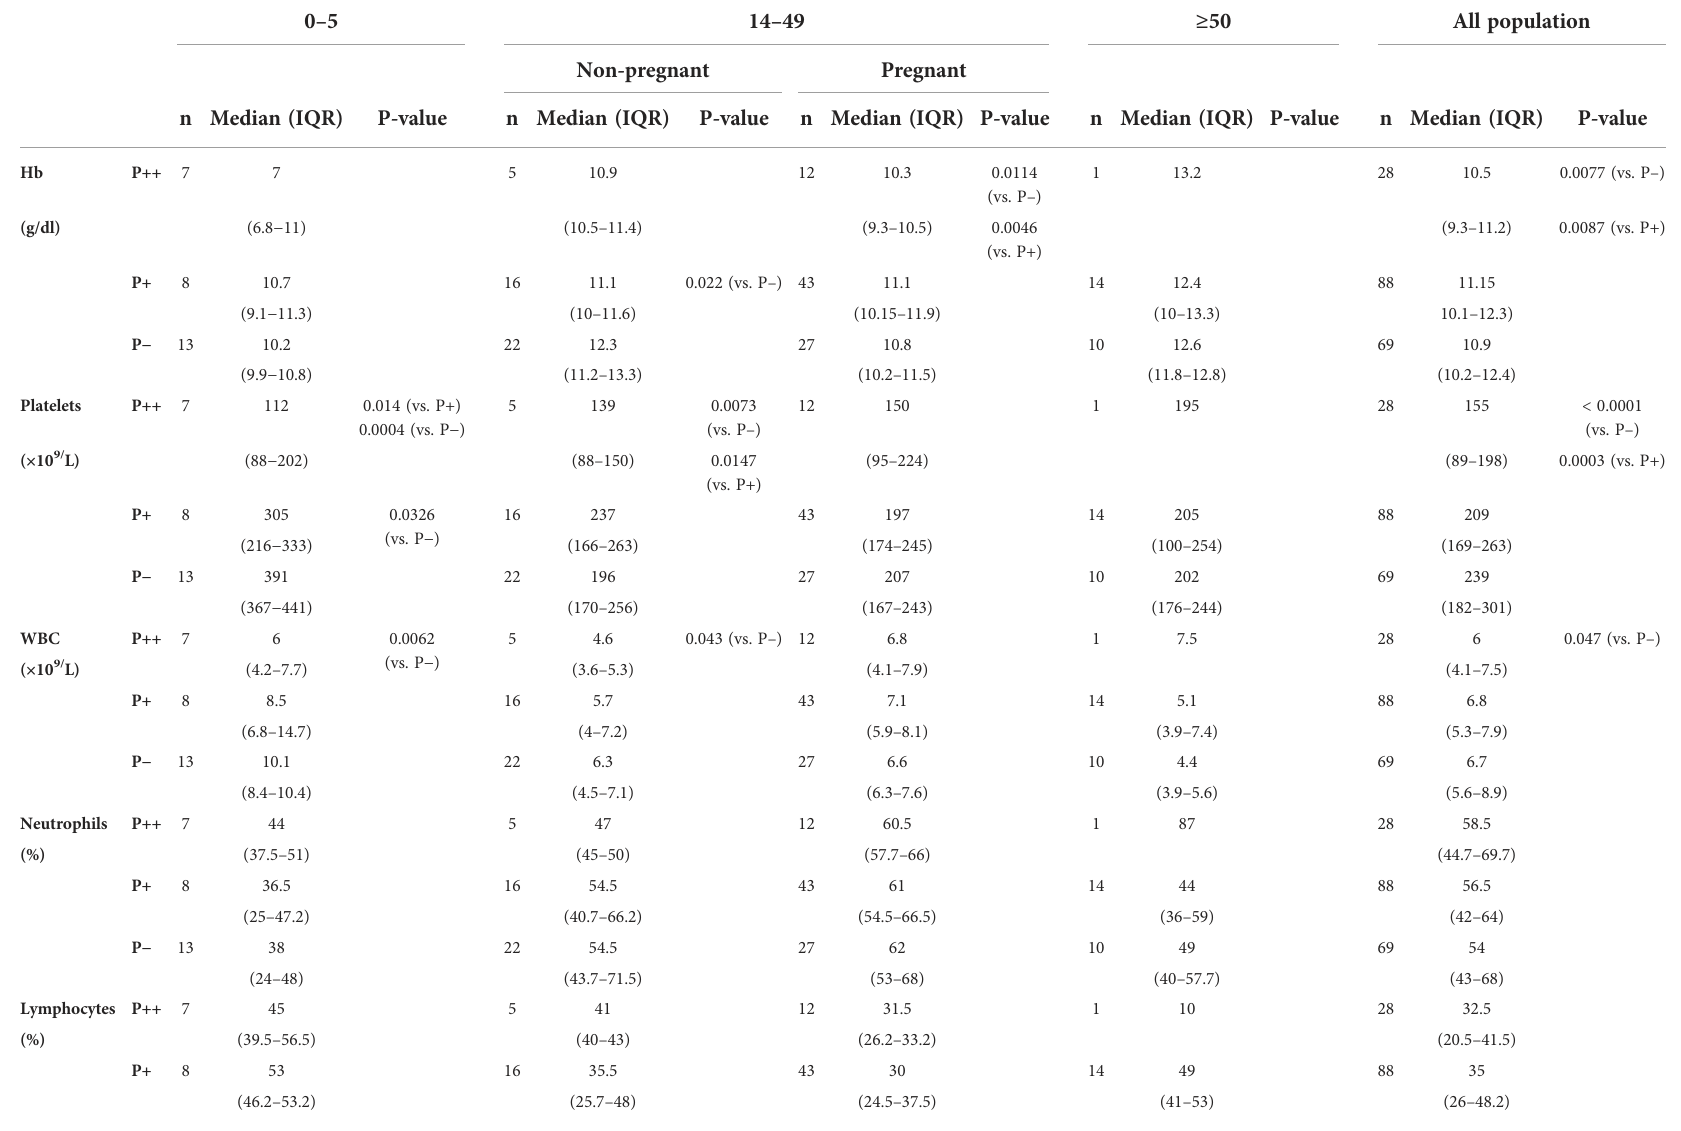
TABLE 3 Effect of malaria infection on hematological variables by age